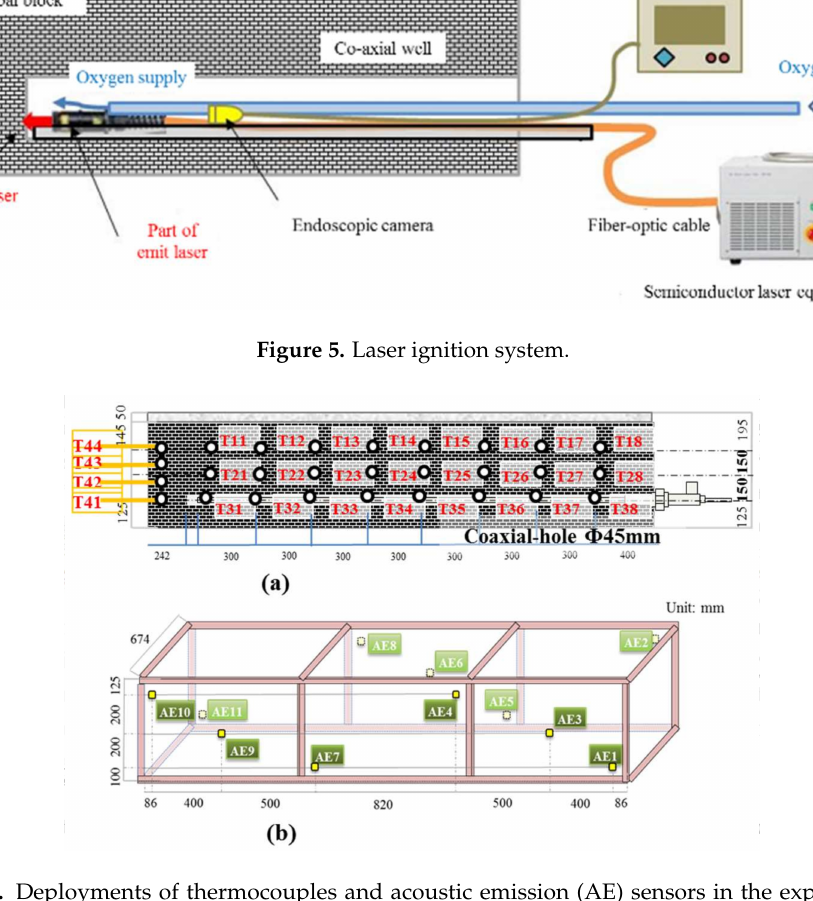
Figure 6. Deployments of thermocouples and acoustic emission (AE) sensors in the experimental model. ( a ) Thermocouples arrangement; ( b ) AE sensors